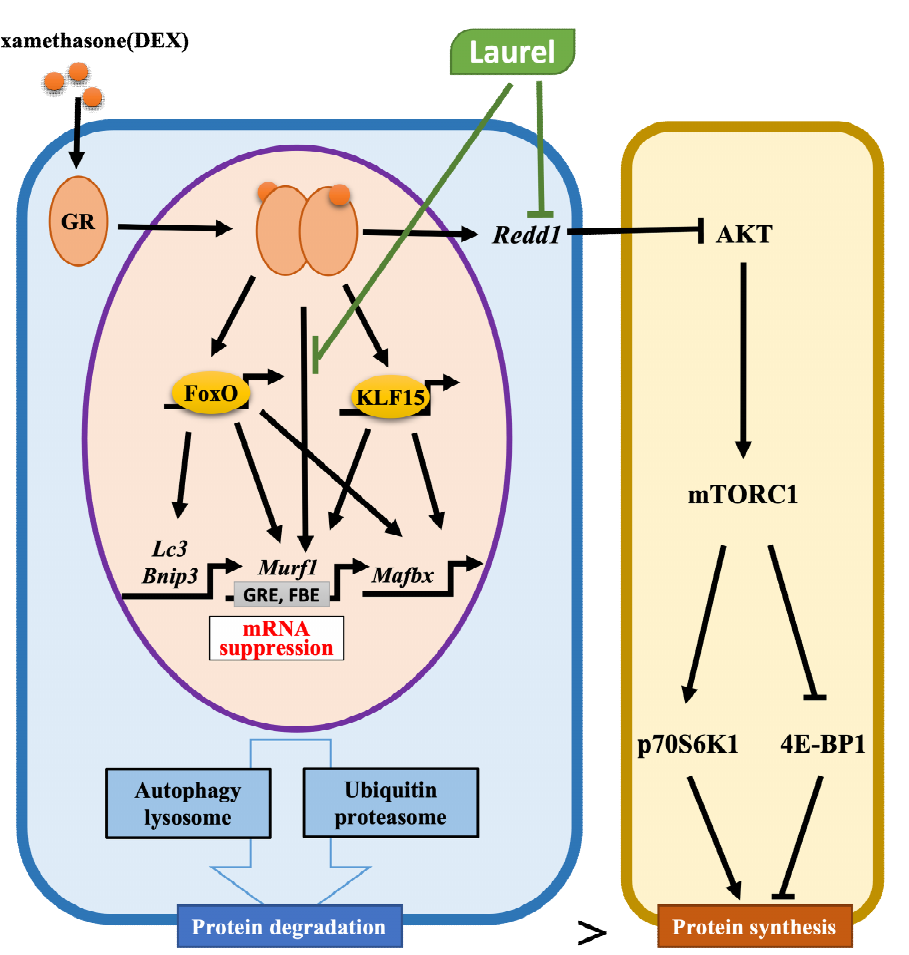
Figure 6. Schematic of the mechanism underlying the attenuation of DEX-induced skeletal muscle atrophy by laurel. Laurel protects against DEX-induced skeletal muscle atrophy by inhibiting the upregulation of MuRF1 mRNA, and regulating the mRNA expressions of Redd1 and Foxo1 in the muscles of rats. Moreover, inhibition of the binding of glucocorticoid receptor (GR) or FoxO1 to glucocorticoid response element (GRE) or FOXO-binding element (FBE), respectively, in the MuRF1 promoter in the skeletal muscle might be the underlying mechanism of the beneficial effects of laurel. Black arrows represent the role of DEX and green arrows represent the role of laurel.